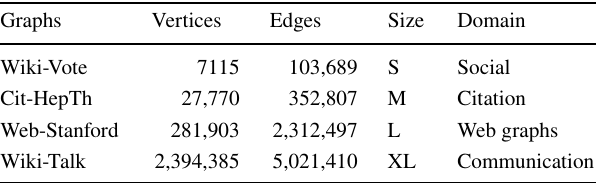
Table 4 The real graph